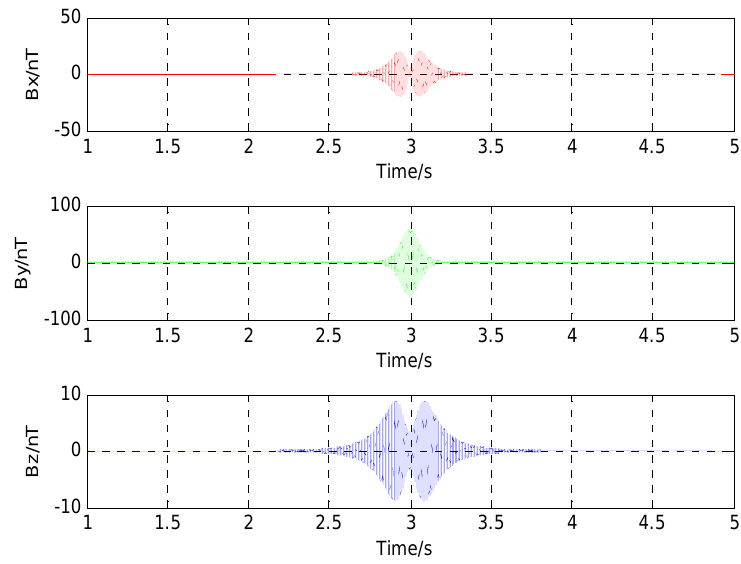
Figure 4. Alternating magnetic field data of the radiation source.